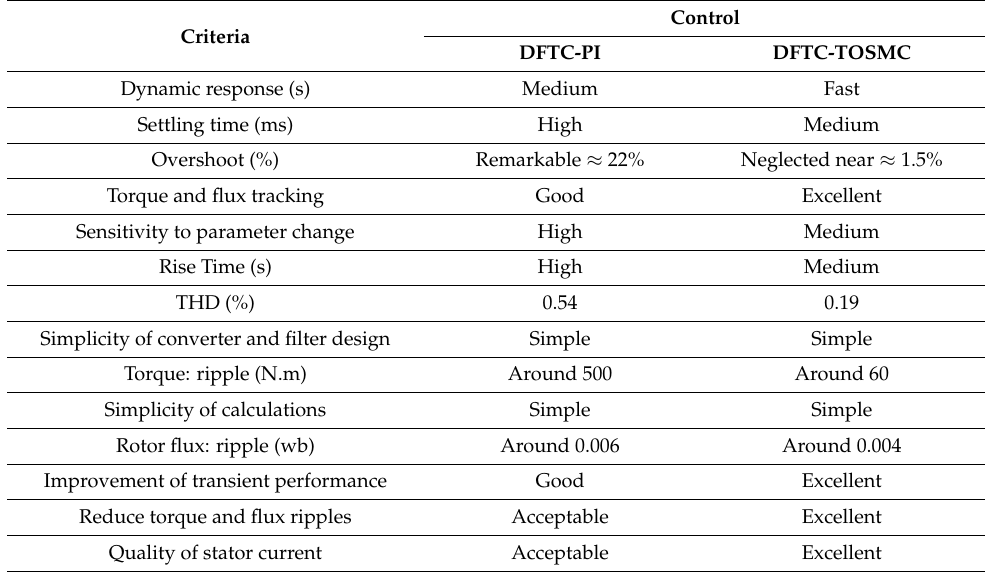
Table 2. Comparison of the results obtained from the proposed method with the classical